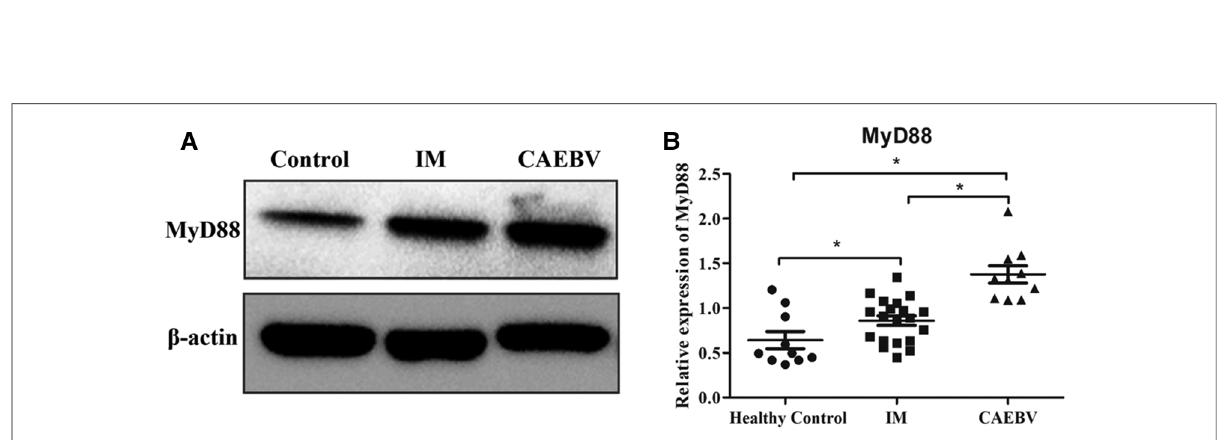
FIGURE 3 Myd88 expression in the EBV-infected patients. ( A ) The protein level of MyD88 in the cytosolic fractions derived from the healthy control, IM patient and CAEBV patient. ( B ) The protein level of MyD88 in healthy controls (age matched, n =20), IM patients ( n =20) and CAEBV patients ( n =10). (* p < 0.05 by Duncan ’ s